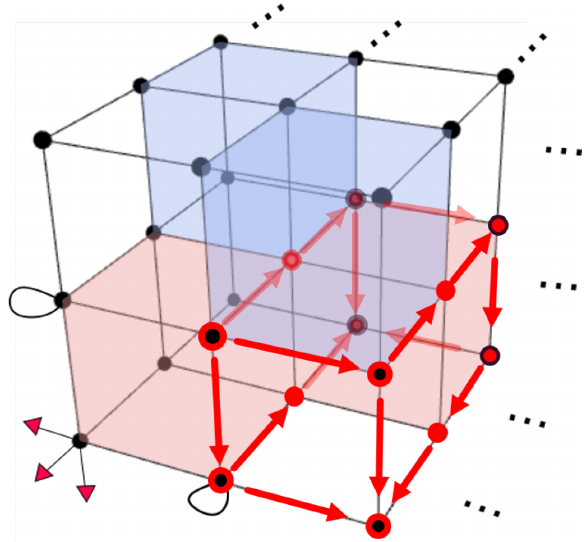
FIG. 24. A tensor network that mimics a 3D cubic lattice. It represents a code where a physical qubit rests on each lattice site in the bulk. There is one logical and one physical dangling leg on each vertex. They are not shown to avoid clutter. The tensor with a yellow curly arrow hovering above is rotated relative to the central tensor by 90 ◦ counterclockwise. The specific boundary conditions has to be treated separately by contracting the dan- gling legs for tensors on the boundary. We show an example for such contraction for the three tensors in the lower left corner.